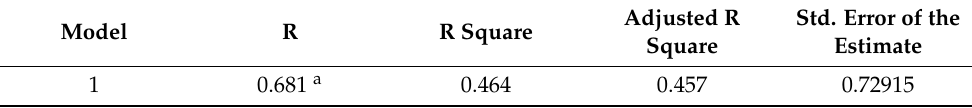
Table 4. Regression 1: SMA with Brand Equity.